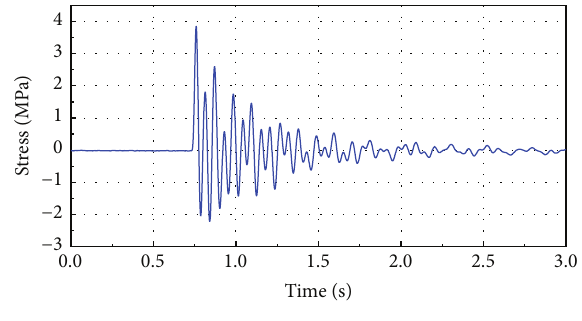
Figure 6: Hammering test in wet condition. Table 3: Testing